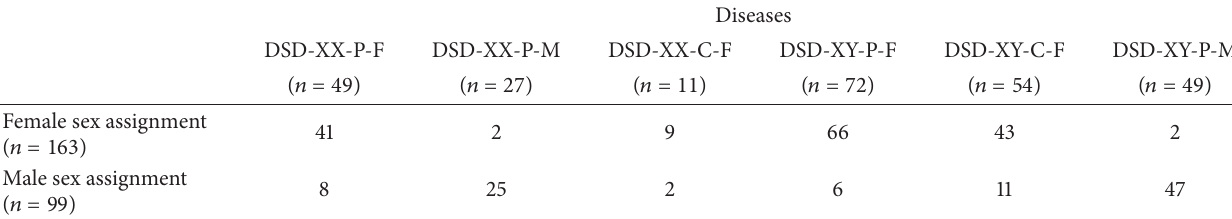
Table 1: Distribution of etiologies in sex assignment of female and male groups.